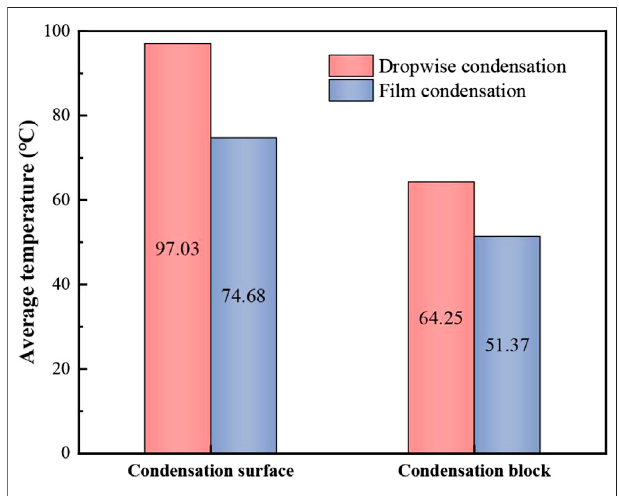
FIGURE 11 | Comparison of the average temperature between dropwise condensation and fi lm